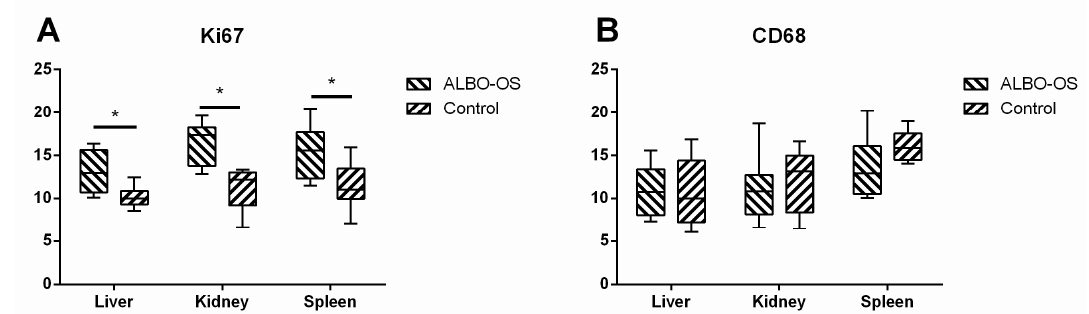
Figure 8. Percentage area of Ki67 ( A ) and immunoreactive CD68 + ( B ) stained cells was calculated with